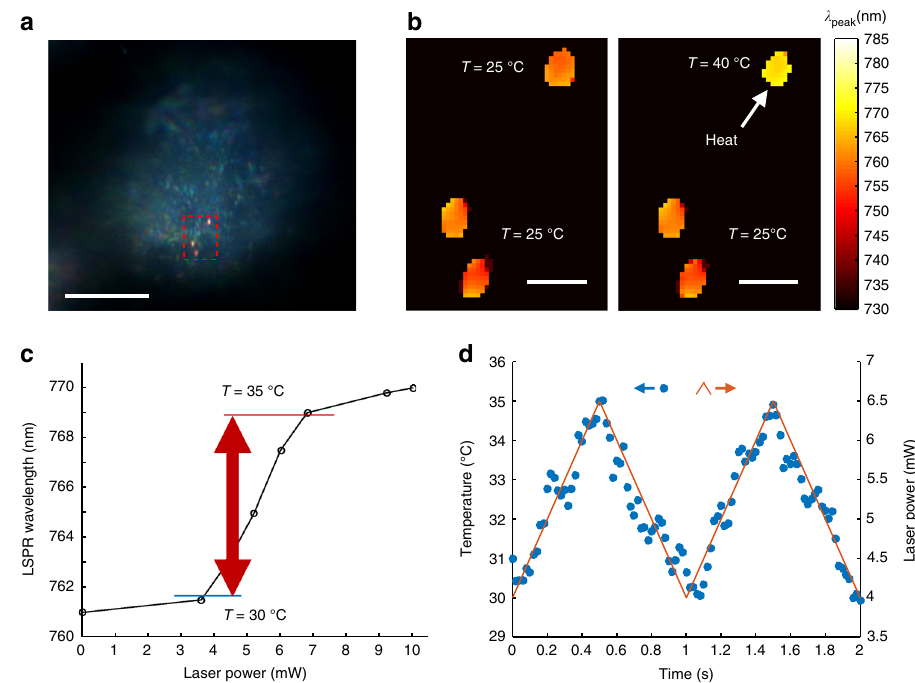
Fig. 6 Illustration of the intracellular thermometry by AuNRs@pNIPAAm/RGD. a Broadband dark- fi eld image of AuNRs@pNIPAAm/RGD particles inside a HeLa cell. The objective focuses on the middle height of the cell to image intracellular particles. Scale bar is 10 μ m. b Spectral mapping of particles with or without the 808-nm laser illumination in the region marked by a dash square in a . Scale bar is 1 μ m. c LSPR wavelength of the heated particle in b as a function of the 808-nm laser power. d Time-dependent applied 808 nm laser power (solid line) and the obtained temperature of the same particle in c